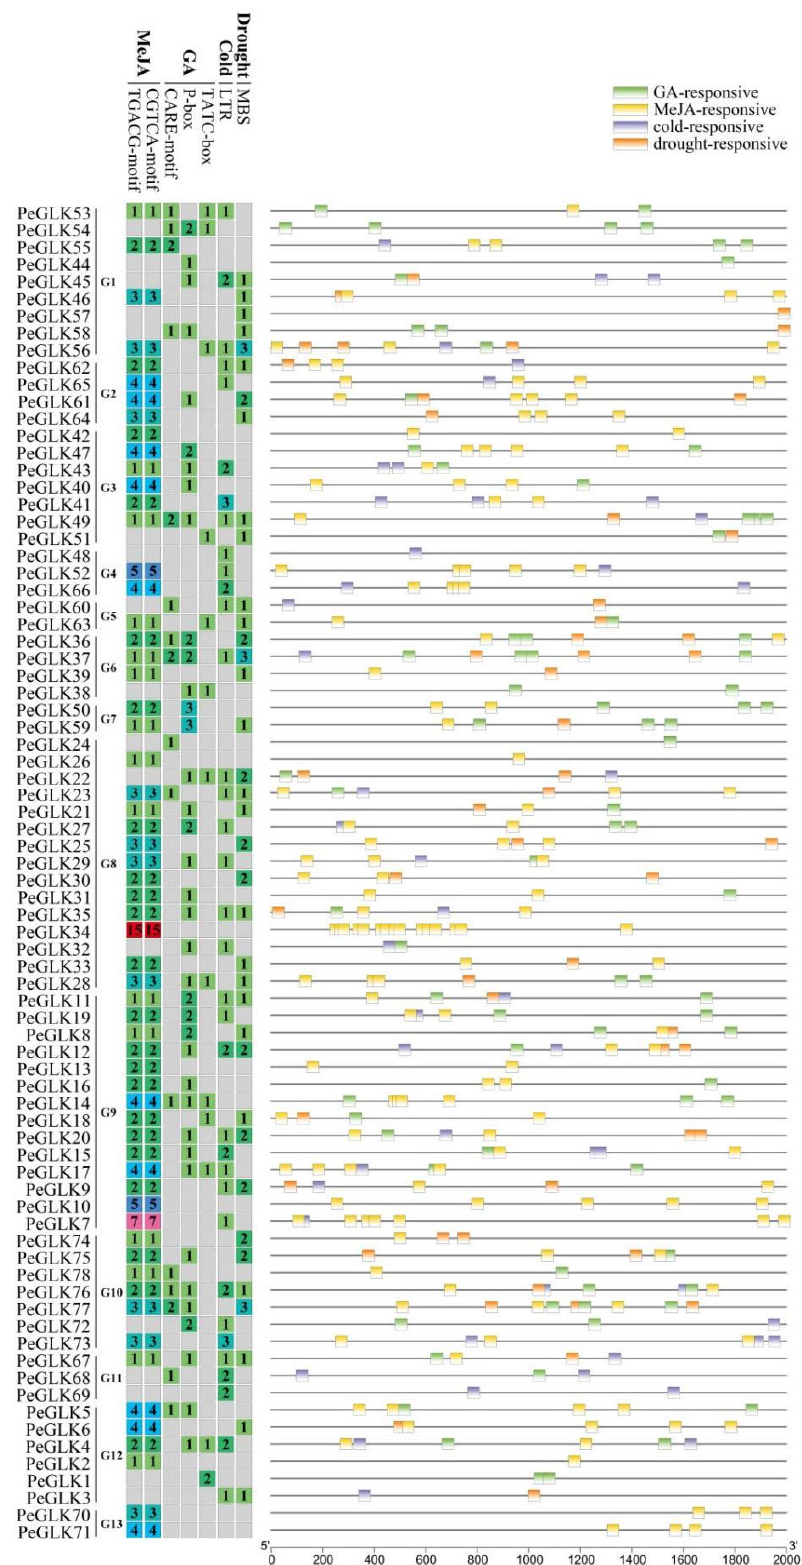
Figure 10. cis ‐ Acting elements related to LTRE, DRE, MeJA, and GA in promoter regions of PeGLKs . Left: Different colors represent numbers of four cis ‐ acting elements of PeGLKs . Right: Four CREs Left: Different colors represent numbers of four cis -acting elements of PeGLKs . Right: Four CREs were predicted; each is displayed in a different color. were predicted; each is displayed in a different